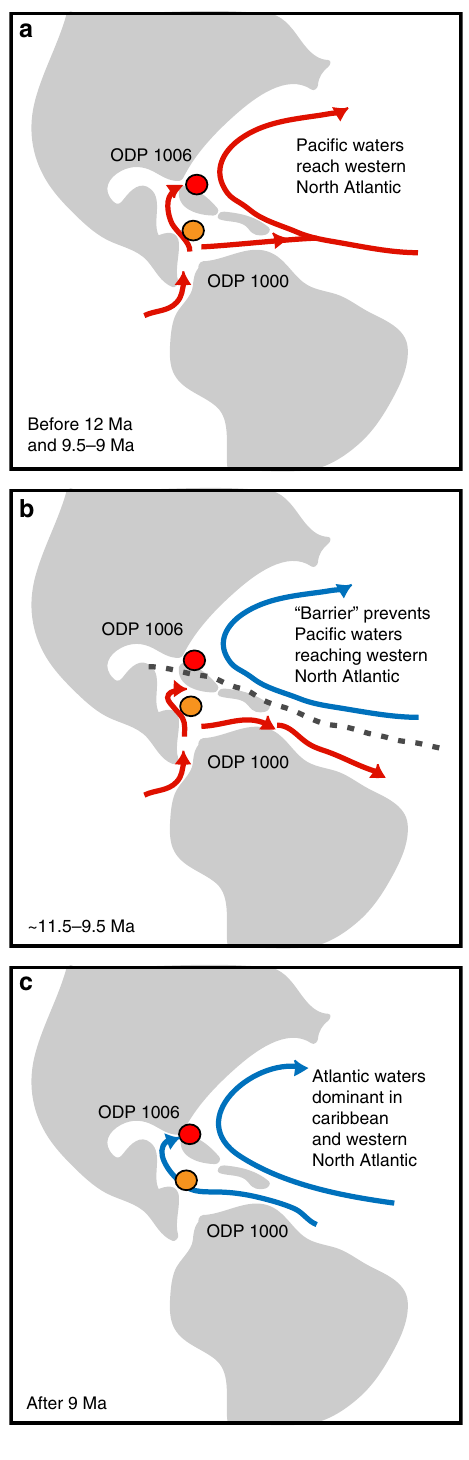
Fig. 5 Schematic representation of different circulation patterns as the Central American Seaway shoaled. a Intermediate-depth water from the Paci fi c reaches the western North Atlantic, either directly via the Florida Strait, or indirectly via entrainment in the Atlantic gyre. Site 1000 (orange circle) and Site 1006 (red circle) both have radiogenic ε Nd signatures. b A barrier (dashed grey line), either physical or hydrographical, prevents Paci fi c intermediate waters from reaching the western North Atlantic. Site 1000 has a more radiogenic signal than Site 1006. c The Central American Seaway has shoaled suf fi ciently so that the Atlantic is the dominant source of intermediate waters to the Caribbean. The detrital signal at Site 1000 changes towards that of the Orinoco after